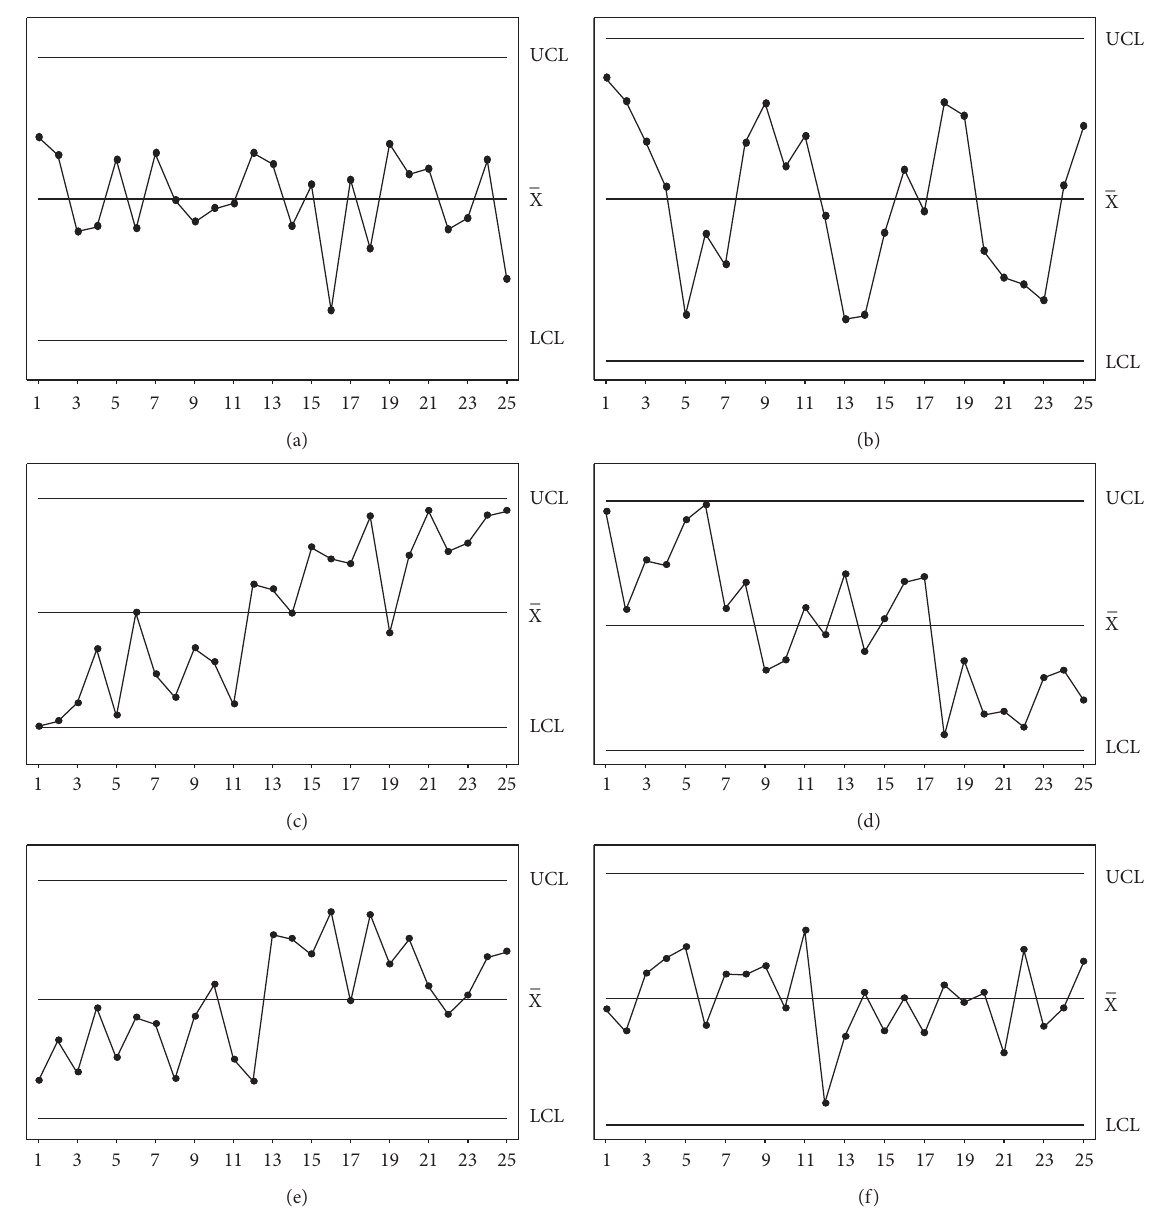
Figure 1: Basic quality anomaly modes: (a) normal mode; (b) cycle mode; (c) upward trend mode; (d) downward trend mode; (e) upward step mode; (f) downward step